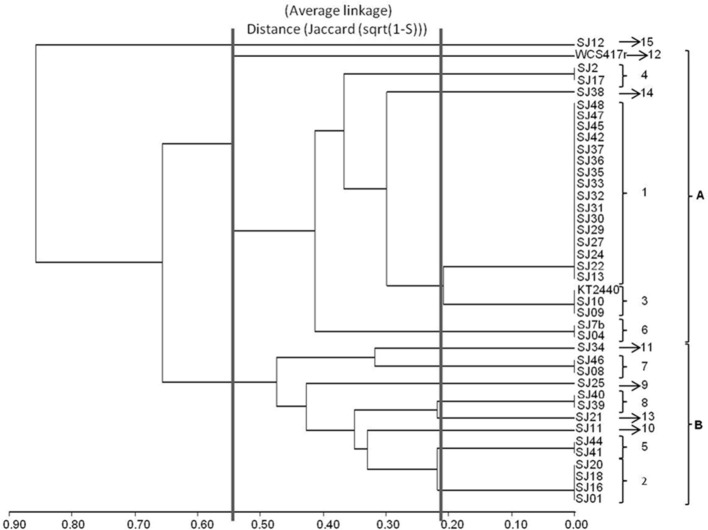
Dendrogram generated from RFLP patterns of 16S rRNA genes of native and reference strains of fluorescent Pseudomonas, using the UPGMA algorithm and Jaccard coefficient.